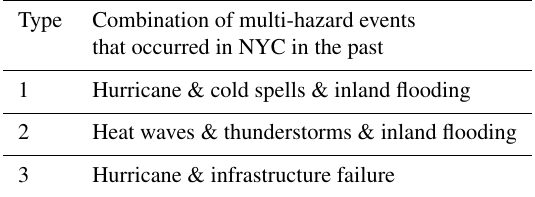
Table 3. List of multi-hazard events that happened in the past ac- cording to the respondents of the